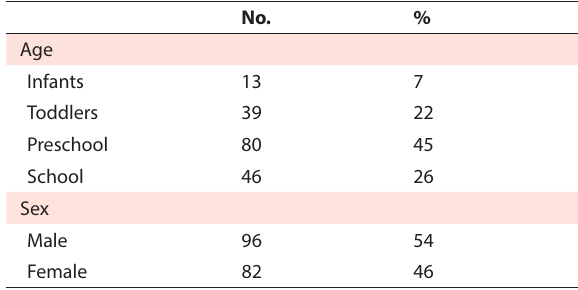
Table 1. Distribution as per age and sex